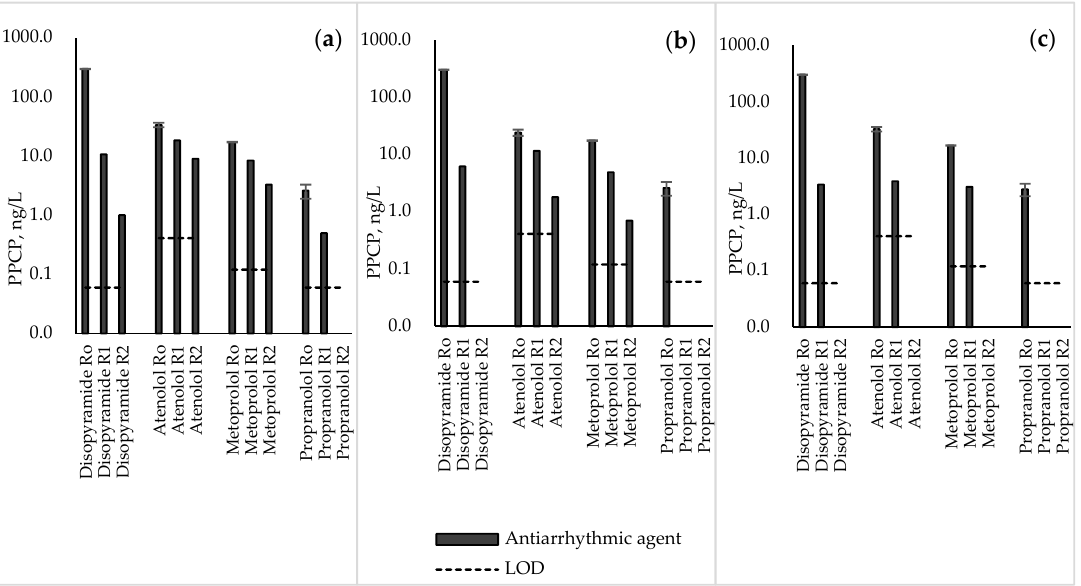
Figure 4. Concentrations of four antiarrhythmic agents in the feed secondary effluent (R o ) and effluent of the R 1 and R 2 reactors at the O 3 doses of: ( a ) 1 and 2 mg L − 1 , respectively, in Run 1; ( b ) 2 and 4 mg L − 1 , respectively, in Run 2; and ( c ) 3 and 6 mg L − 1 , respectively, in Run 3.